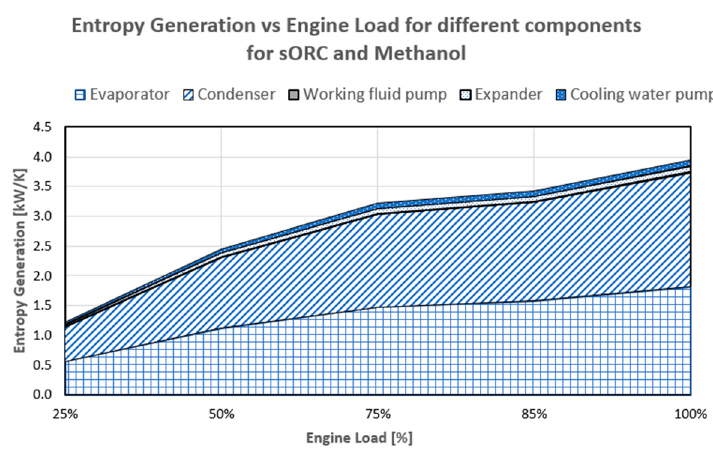
Figure 12. Entropy generation rate vs engine load for methanol sORC. 401